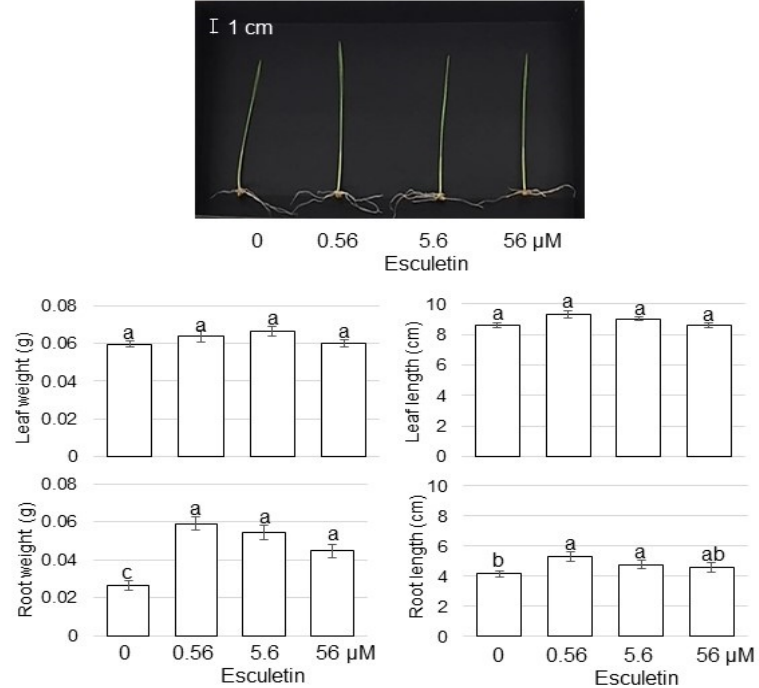
Figure 7. Morphological change by application of lipoxygenase inhibitor to wheat. As lipoxygenase inhibitor, esculetin, was used. Three-day-old wheat seedlings were treated with or without 0.56, 5.6, and 56 µ M escletin for 3 days. Leaf-fresh weight, leaf length, total root-fresh weight, and main-root length were measured. Scale bar in the picture shows 1 cm. The data are presented as mean ± SD from 3 independent biological replicates. Statistical analysis is the same as Figure